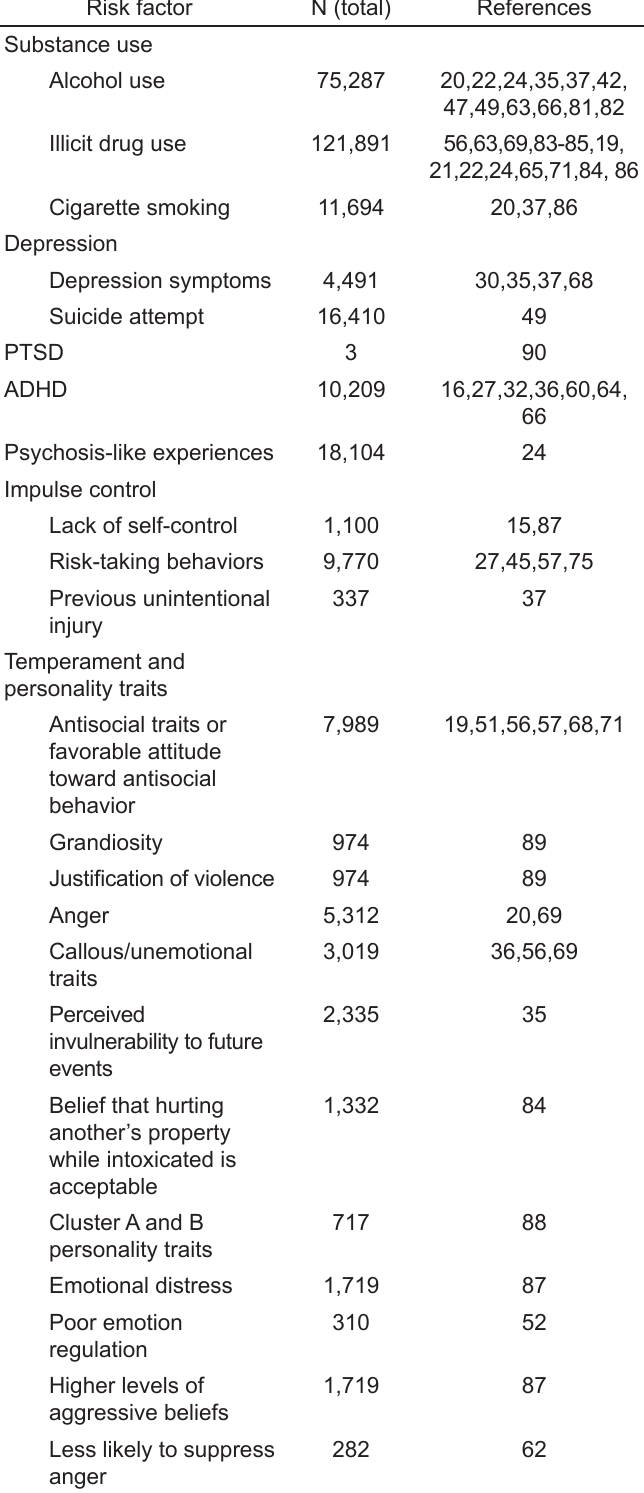
Table 4. Clinical risk